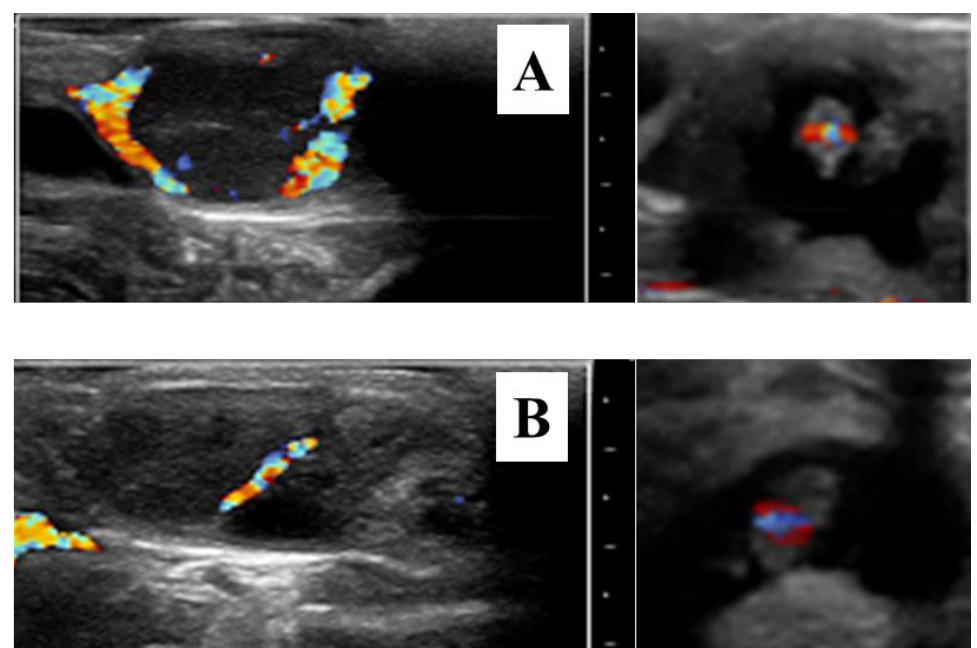
Figure 1. Color-flow sonograms of corpora lutea and their corresponding 30-day embryos showing normal ( A ) and low luteal vascular perfusion ( B ). The apparent luteal vascular decrease in ( B ) compared to that of ( A ) was associated with pregnancy loss 14 days later. All images were selected on the basis of maximal vascular perfusion from real-time video clips. Bar spacing: 10 mm.